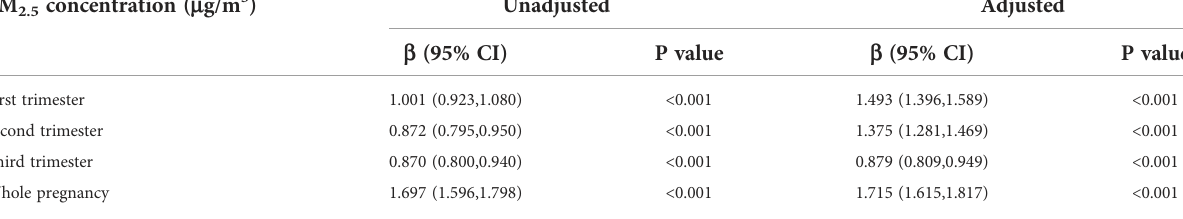
TABLE 2 Linear regression between PM 2.5 concentration and birth weight a .